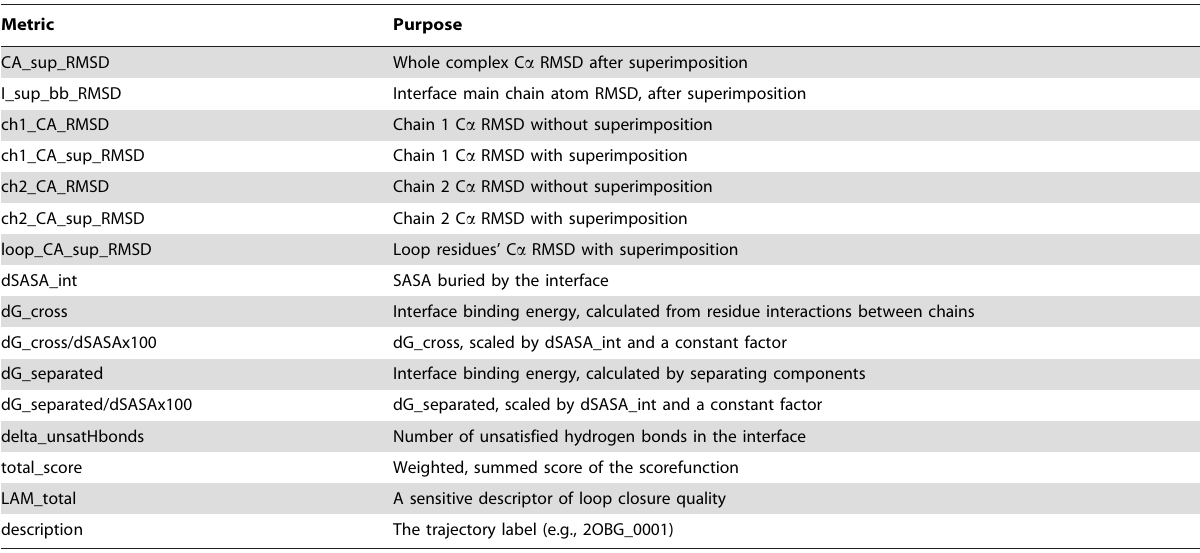
Table 1. Annotated scorefile headers.